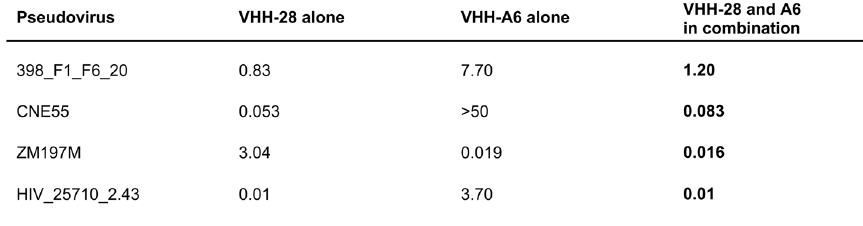
Figure 4. Neutralization activity of purified VHHs against a standard panel of pseudoviruses comprising different clades and neutralization sensitivities. VHHs were tested against a panel of pseudoviruses in the TZM-bl assay. Neutralization sensitivities are colour-coded according to the IC 50 values: dark red corresponds to IC 50 < 0.1 µ g/ml, light red is from 0.1–1 µ g/ml, orange is from 1–10 µ g/ml and yellow is from 10–50 µ g/ml.